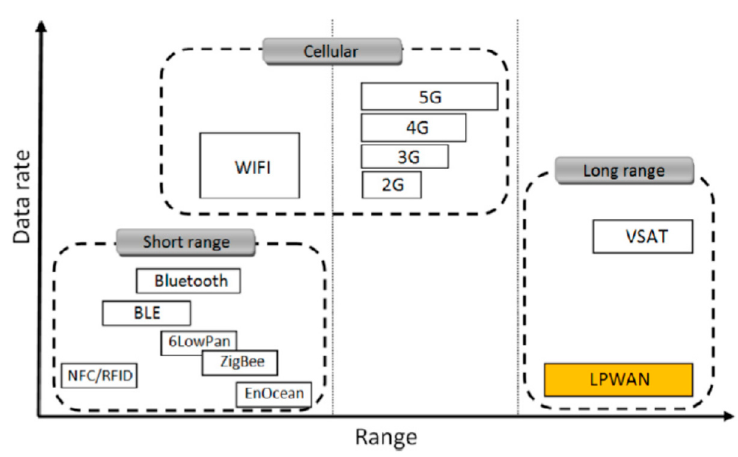
Figure 1. Data rate vs. range in communication networks. Source: [27].